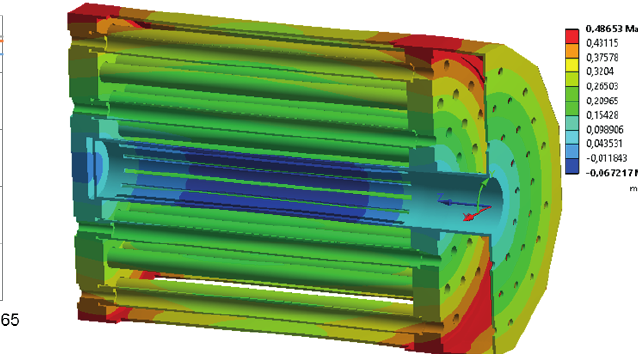
Figure 25: Radial displacement of the assembly with supporting structure under thermal